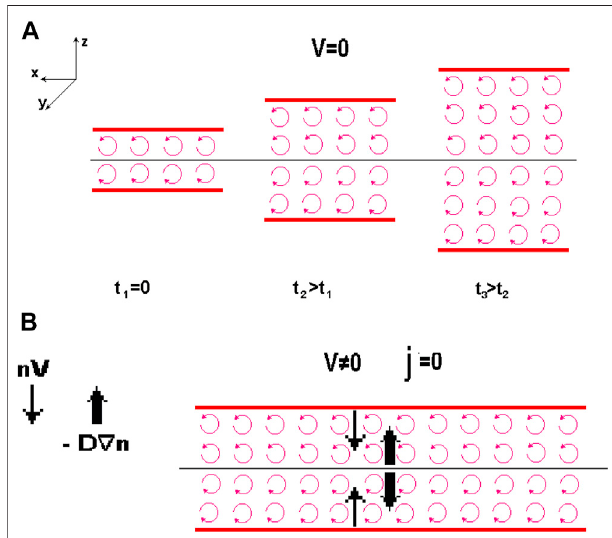
FIGURE 4 | Scheme illustrating the formation of the turbulent plasma sheet. Case (A) corresponds to the expansion of the sheet due to eddy diffusion when the regular fl ow velocity V (cid:2) 0, case (B) corresponds to the quasistable con fi guration, when the regular velocity to the tail center compensates the eddy